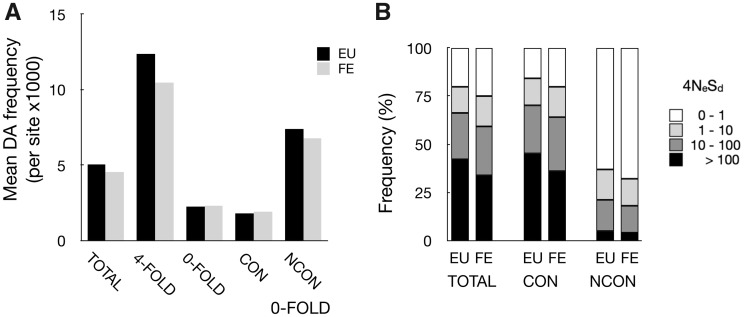
(A) Mean frequency of derived alleles (DAs) per site at different categories of sites in Europe and Far East. (B) Proportions of sites in different categories of severity of deleterious effect (4NeSd) in Europe and FE; all sites (TOTAL); outgroup-aa. Conserved (CON); and nonconserved (NCON).